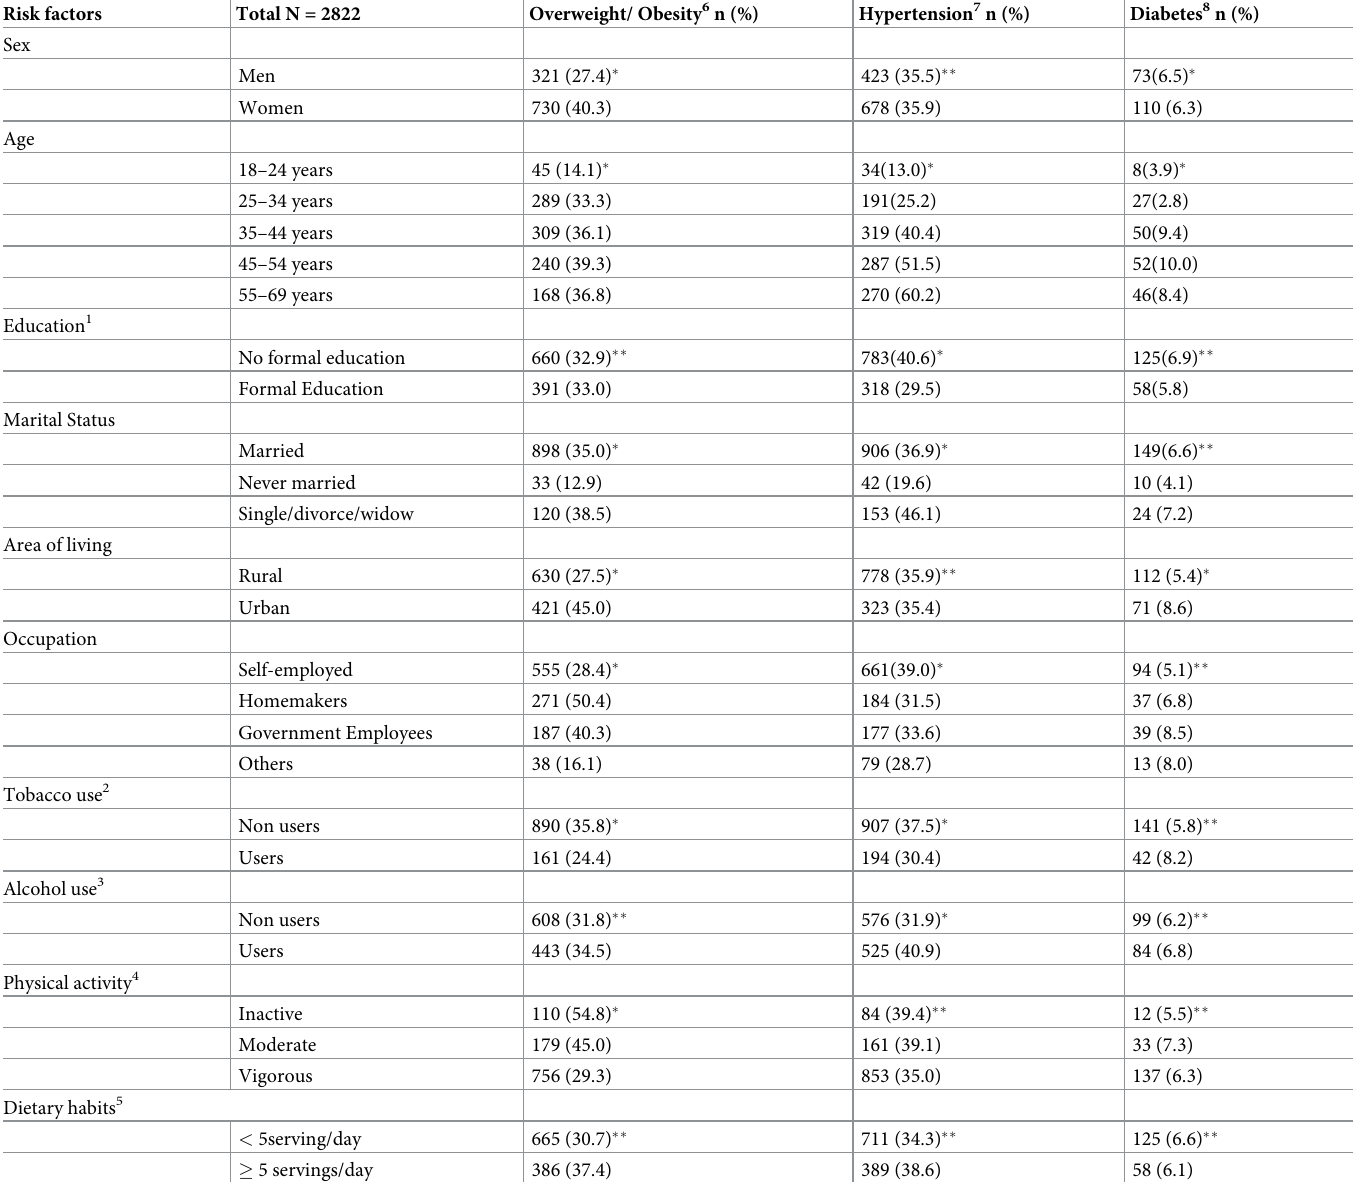
Table 2. Bivariate analysis of factors associated with overweight or obesity, hypertension,